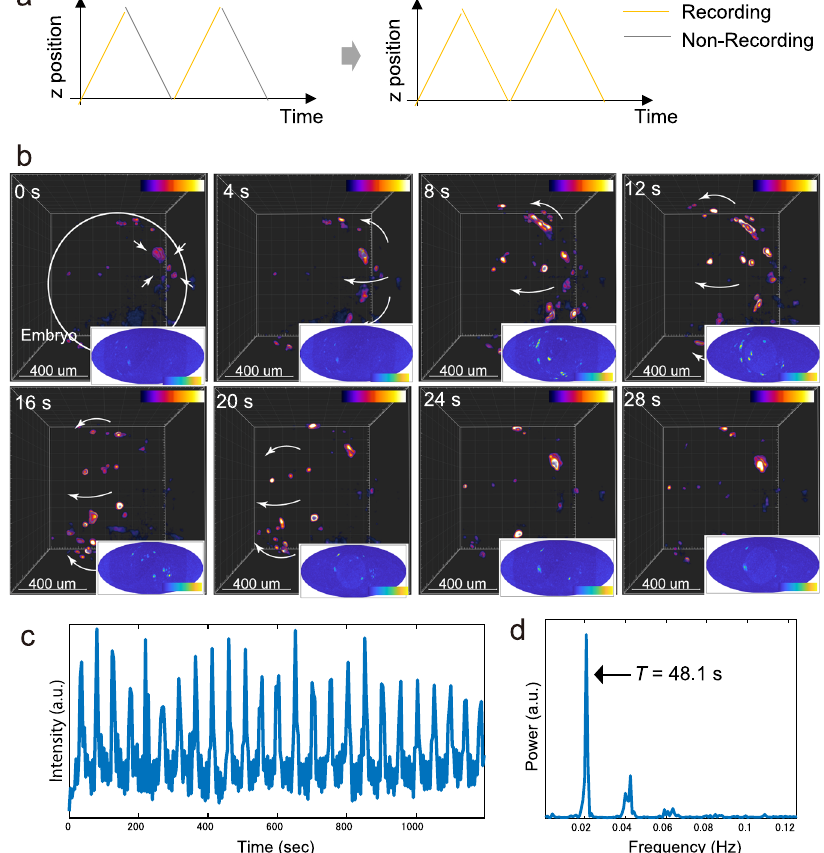
Fig. 8 Fast 4D imaging of intercellular propagating Ca 2 + wave. a Change of the recording mode. To-and-from bidirectional recording mode are implemented. b 4D time-lapse imaging of a GCaMp6f expressed Medaka embryo (1 dpf). Fluorescent signals propagating over the outer layer surrounding whole embryos are indicated. Bottom-right images are two-dimensionally projected maps of the signal using the Mollweide cartography technique. c Plot of the GCaMP6f signal in a small ROI as a function of time. a.u. arbitrary unit. d Fourier analysis of the oscillatory expression of the GCaMP6f signal. a.u., arbitrary